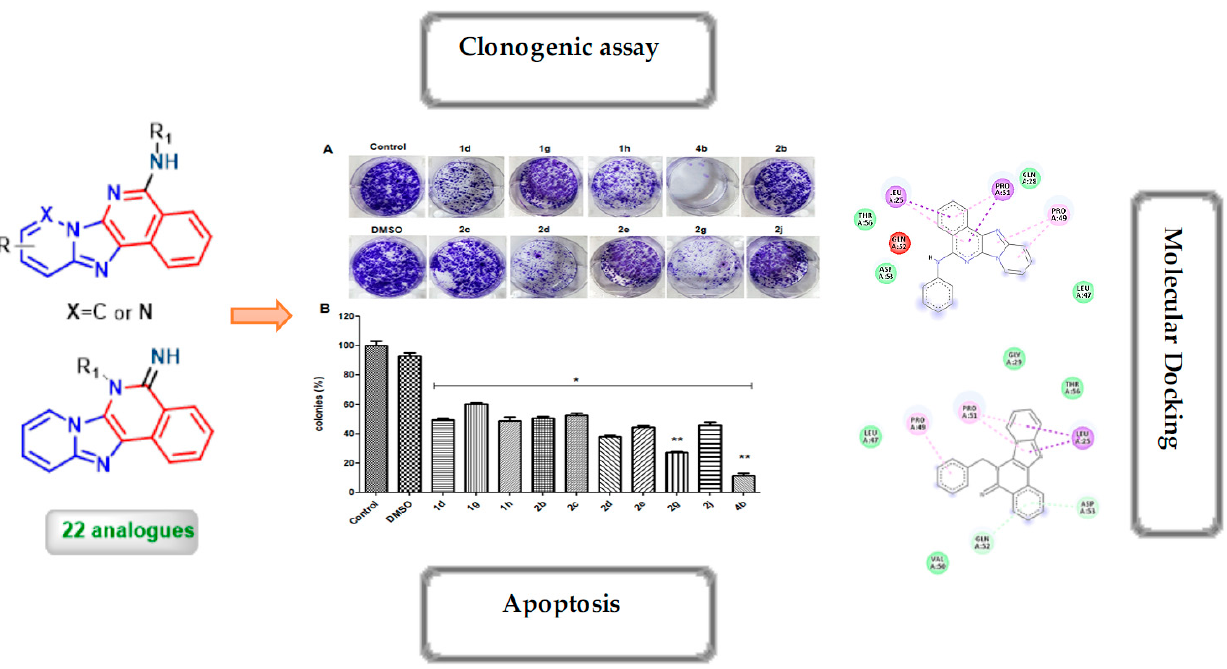
Figure 2. Scheme summarizing the results of this study. ( A ) Representative images of clonogenic assay in SH-SY5Y cells treated with the indicated drugs at 10 μ M. ( B ) Percentage of viable clones after drug treatments with respect to untreated cells. * p < 0.01 significant difference from control group, ** p < 0.01 significant difference from other compounds.